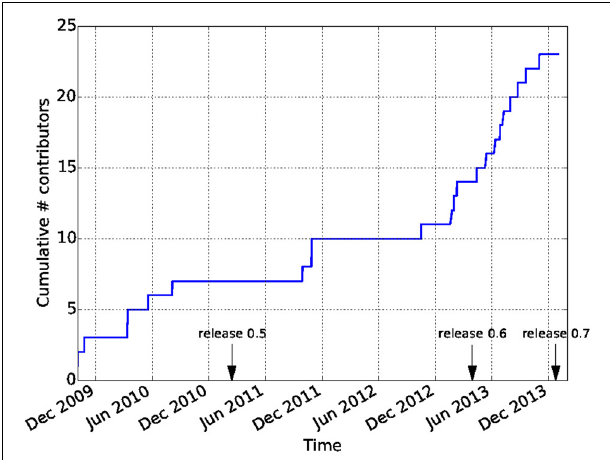
FIGURE 9 | Participation in the Dipy GitHub repository. The cumulative number of unique contributors has been extracted using the git log command and tallied. Many new contributors have joined the project after the 0.6